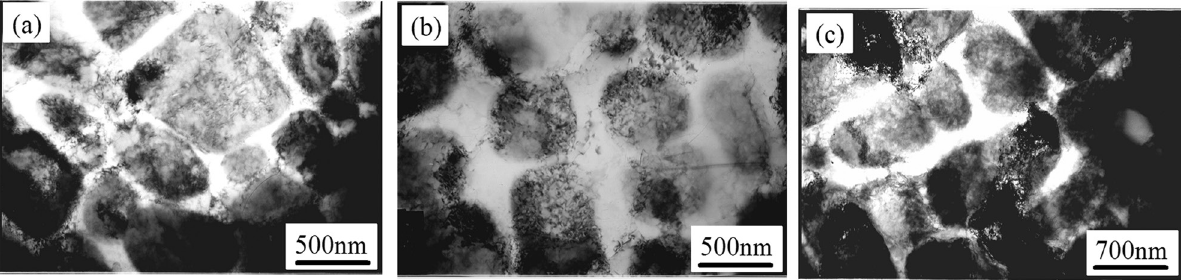
Fig. 3: Deformation structure of aged alloy at intermediate temperatures: (a) high density dislocations in γ′ phase at 760 °C, (b) dislocation tangling at 760 °C, (c) deformation structure at 900 °C